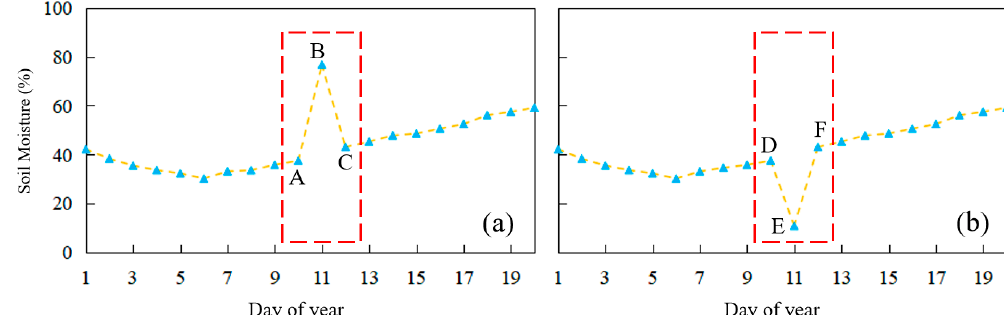
Figure 4. Schematic of abnormal soil moisture in the soil moisture increased stage. ( a ) soil moisture at time A less than at time B and C, but that at time B greater than at times C. ( b ) soil moisture at time E less than at time D but that at time F greater than at times E and D.